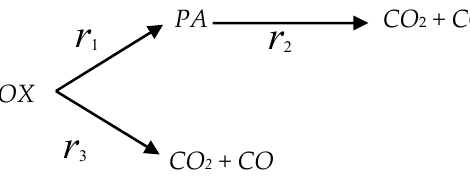
Table 4. Kinetic data for the conversion of o-xylene to phthalic